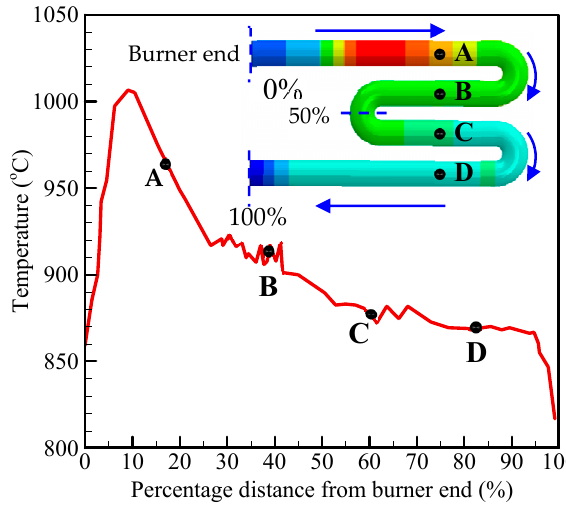
Figure 4. Measured temperature profile in the length direction of the actual RT.